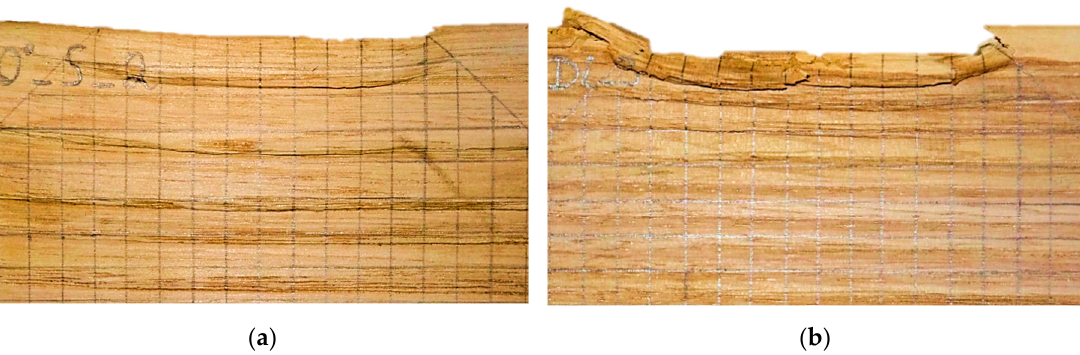
Figure 9. Crushing w perpendicular to the grain under the loaded area obtained after the tests for the sound ( a ) and insect-deteriorated ( b ) timber samples. Meshing dimensions of 5 × 5